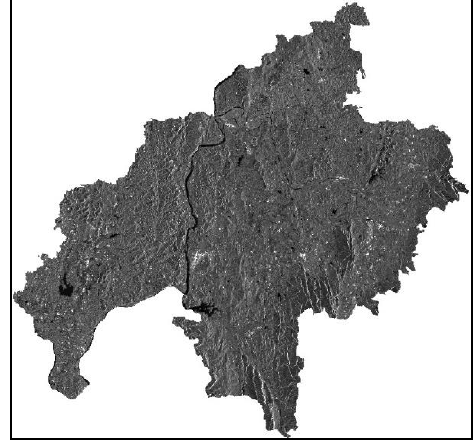
Figure 2. The geocoded GF-3 SAR